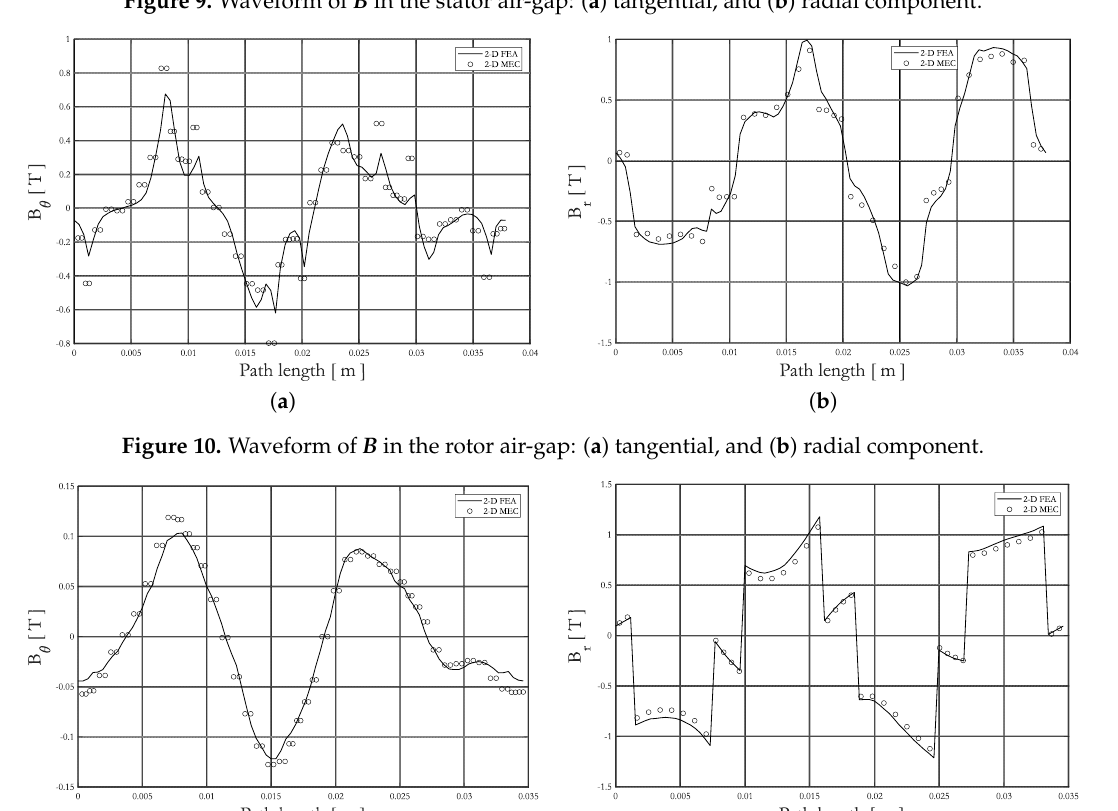
Figure 9. Waveform of B in the stator air-gap: ( a ) tangential, and ( b ) radial component.